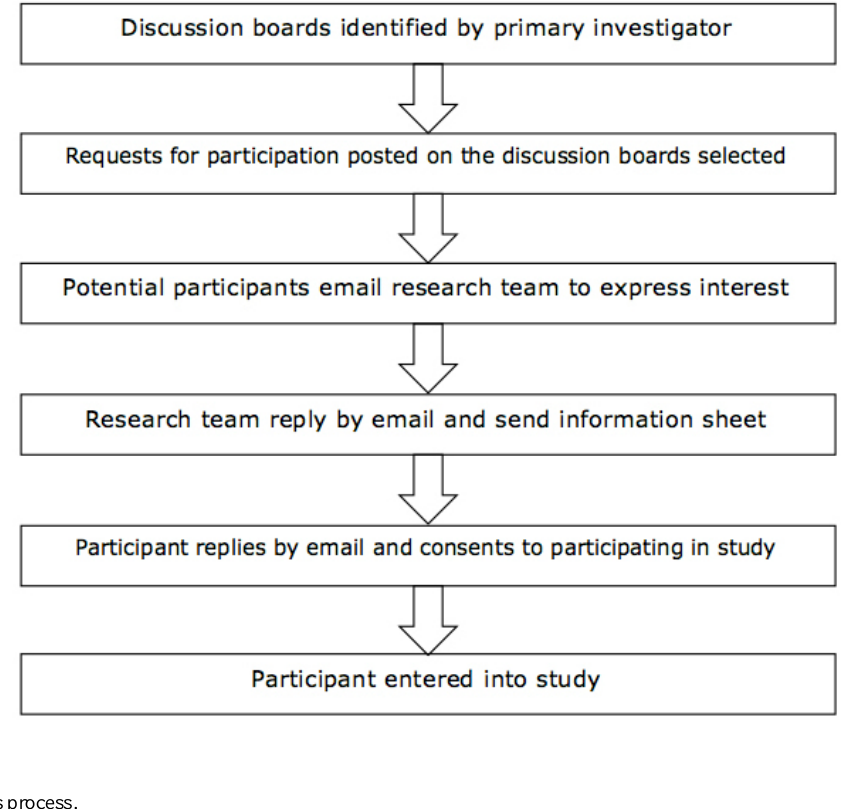
Figure 2. Data analysis